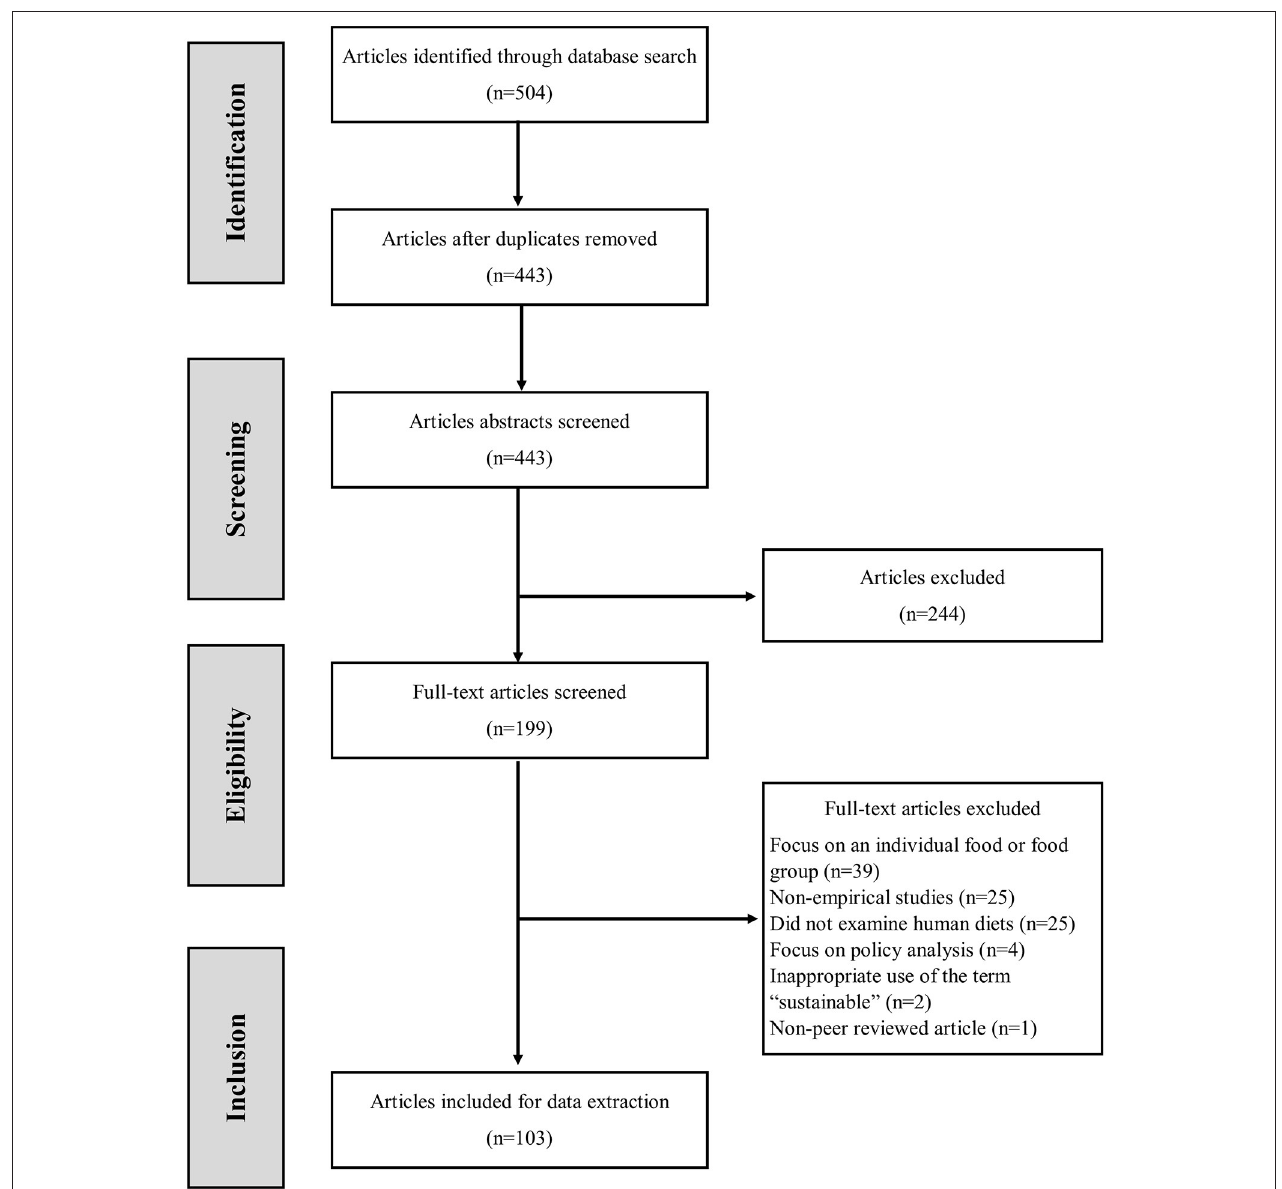
FIGURE 1 | PRISMA diagram of article identification and selection for qualitative